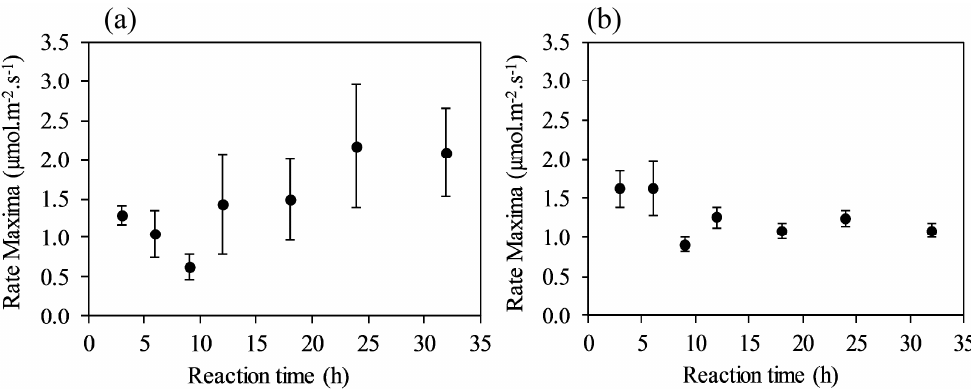
Figure 6. Statistical parameters (average and standard deviation) of the maximum rates of the map sequences of Figure 3c,d: ( a ) Striated surface morphology; ( b ) hill-and-valley surface morphology.